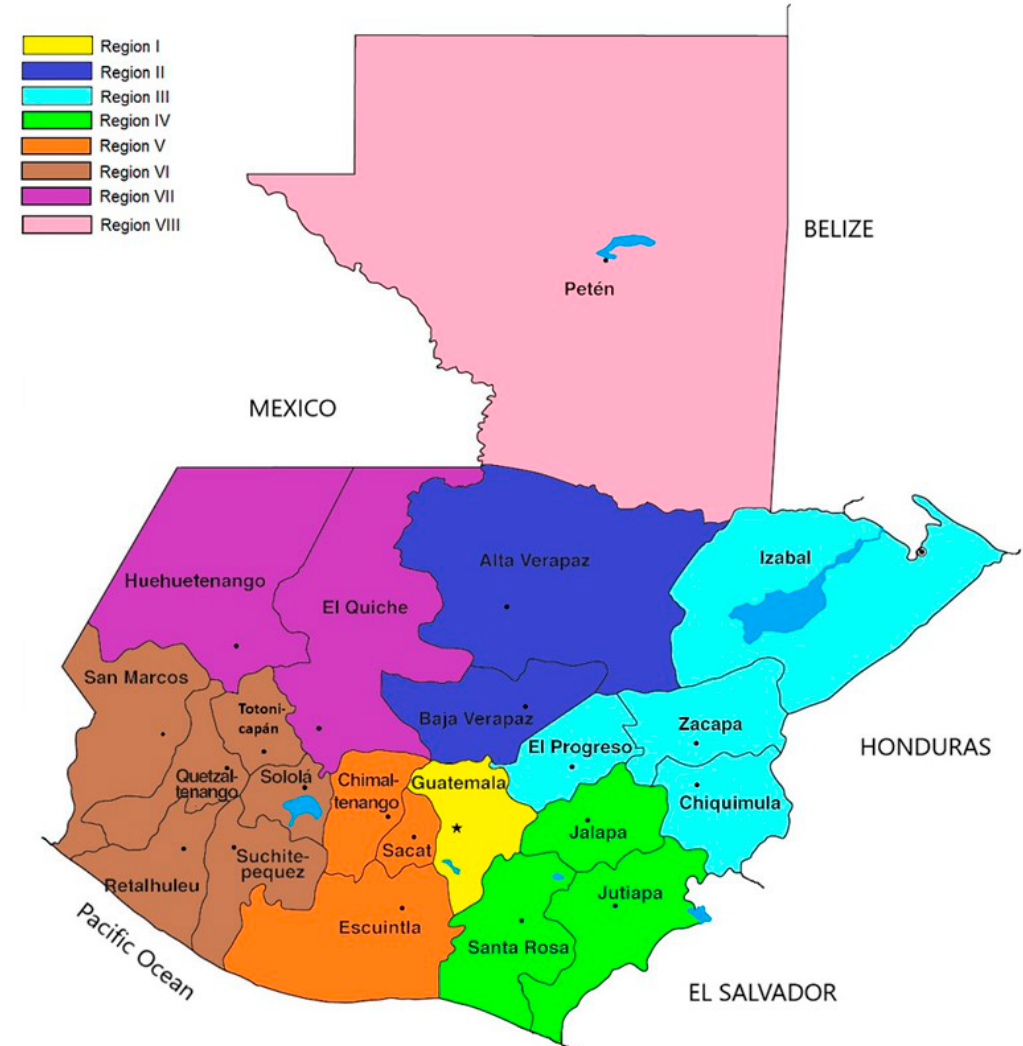
Figure 1. Map of the territorial division of Guatemalan departments.